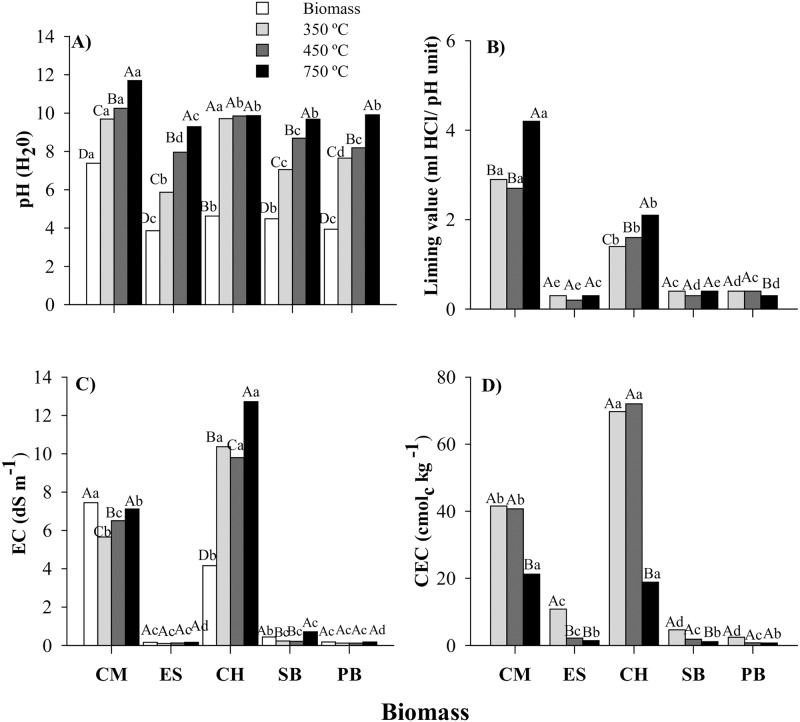
Values of pH-H20 (A), liming value (B), EC—electrical conductivity (C), and CEC—cation exchange capacity (D) as related to biomass and biochars.CM = chicken manure, ES = eucalyptus sawdust, CH = coffee husk, SB = sugarcane bagasse, and PB = pine bark. Uppercase letters compare pyrolysis temperatures within the same biomass and lowercase letters compare biomass at the same temperature. Bar followed by the same letter do not differ by the Tukey test at p <0.05.